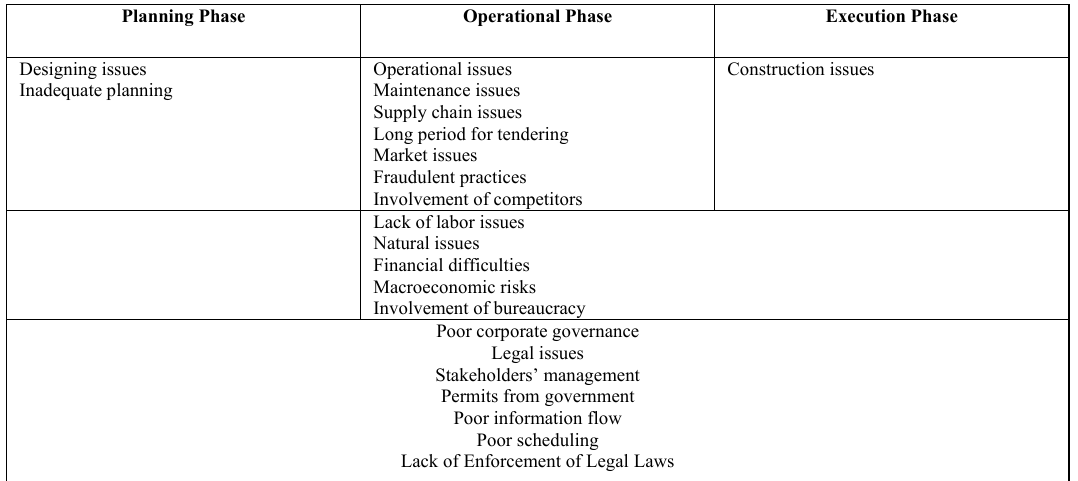
Fig. 6. Project Failures Factors at Each Stage of Project